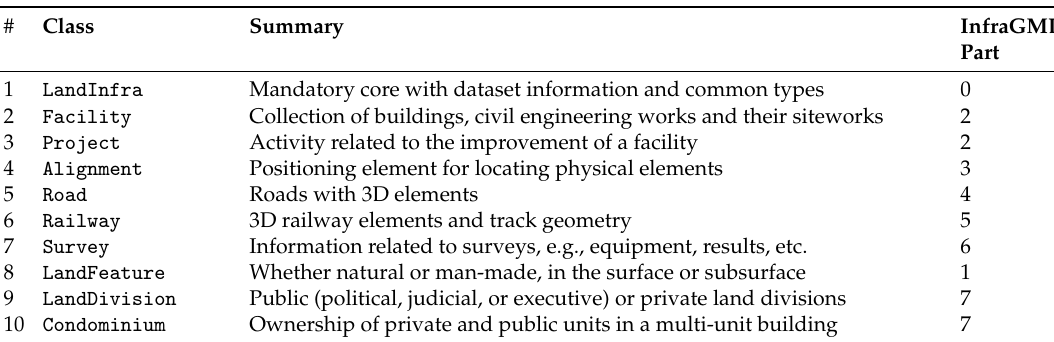
Table 1. Main LandInfra requirements